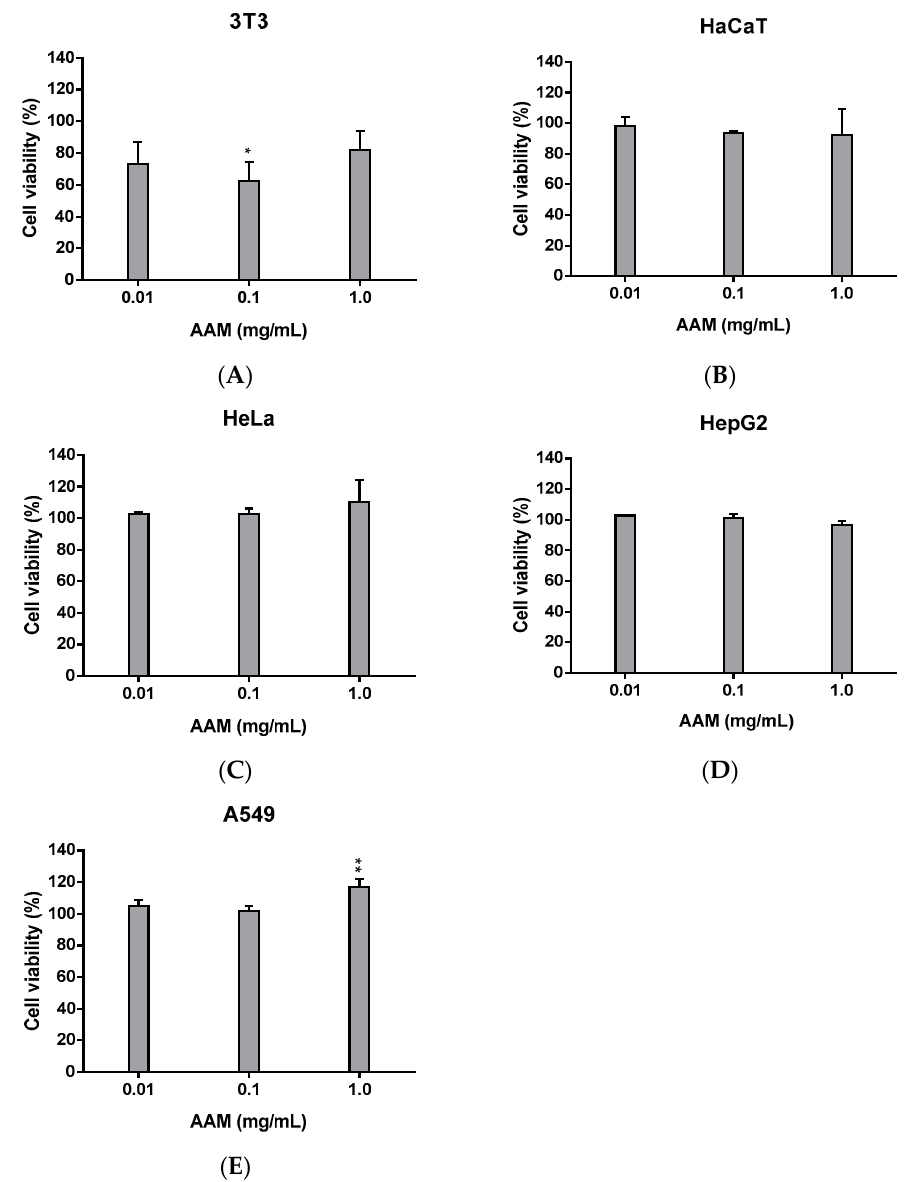
Figure 2. Cytotoxic activity of AAM in 3T3 ( A ), HaCaT ( B ), HeLa ( C ), HepG2 ( D ), and A549 ( E ) cell lines obtained by MTT assay and expressed as percentage of cell viability with respect to control cells. Results are expressed as mean ± standard error of n = 3. Control or untreated cells were maintained with culture medium. A two-way analysis of variance (ANOVA) and a Bonferroni post hoc assay have been performed. Statistical differences were considered as follows: * p ≤ 0.05, and ** p ≤ 0.01 in comparison with untreated cells (negative control).